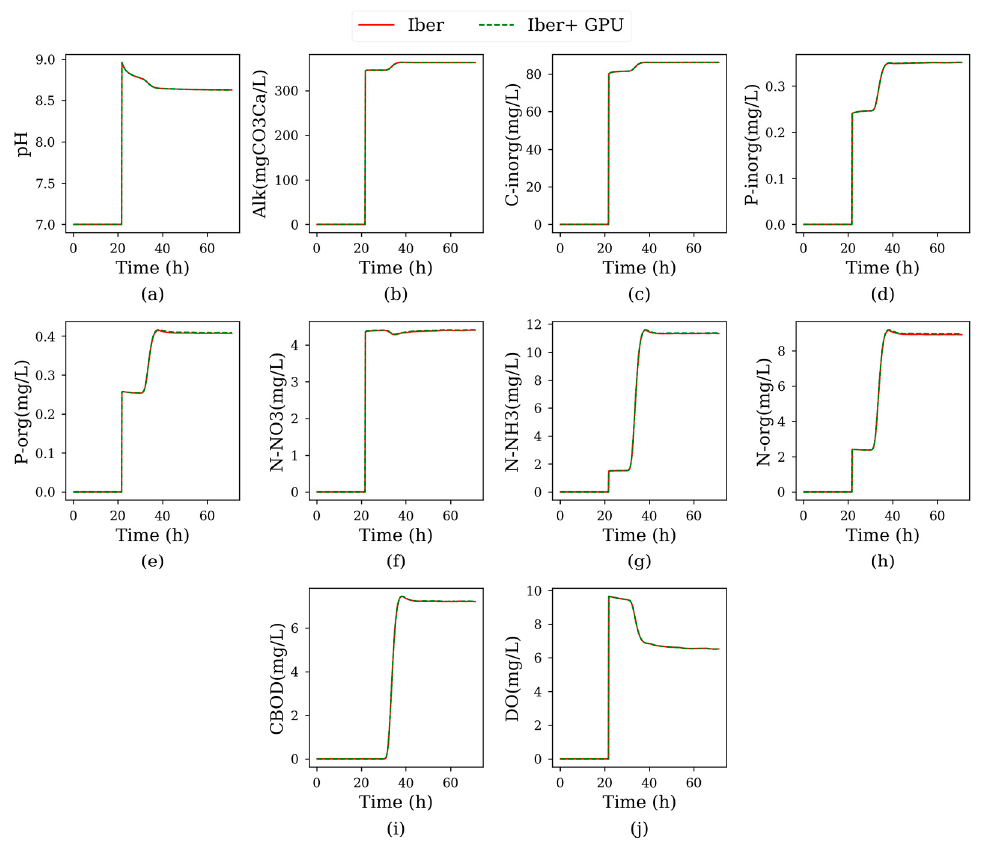
Figure 13. Time series for the analyzed species in Test 4, sampled at control point P3.